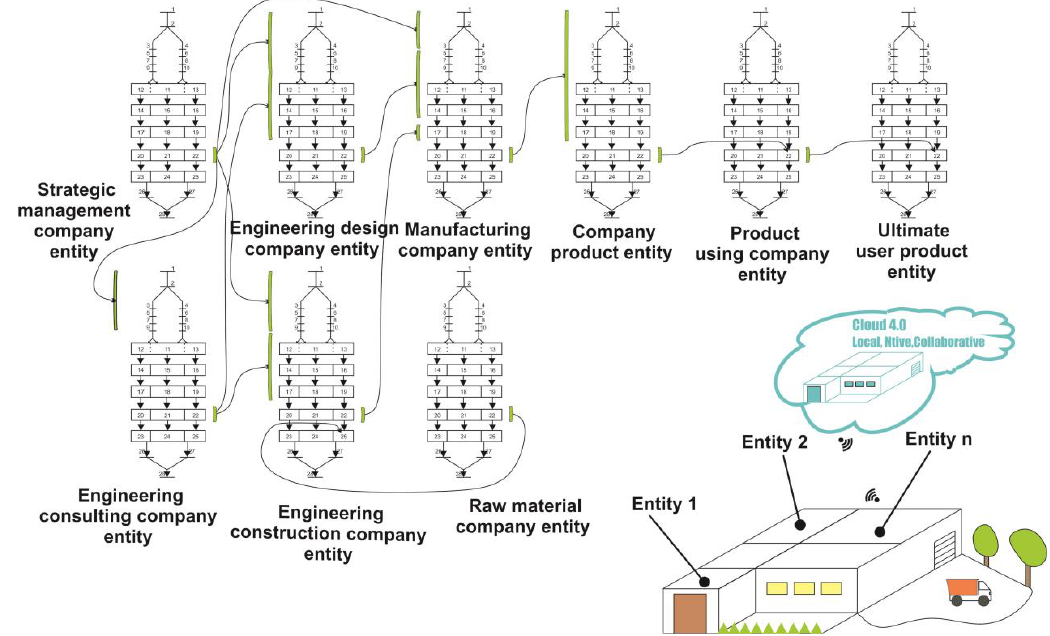
Figure 8. Entities and processes for the company in Purdue Enterprise Reference Architecture (PERA) 4.0 architecture.